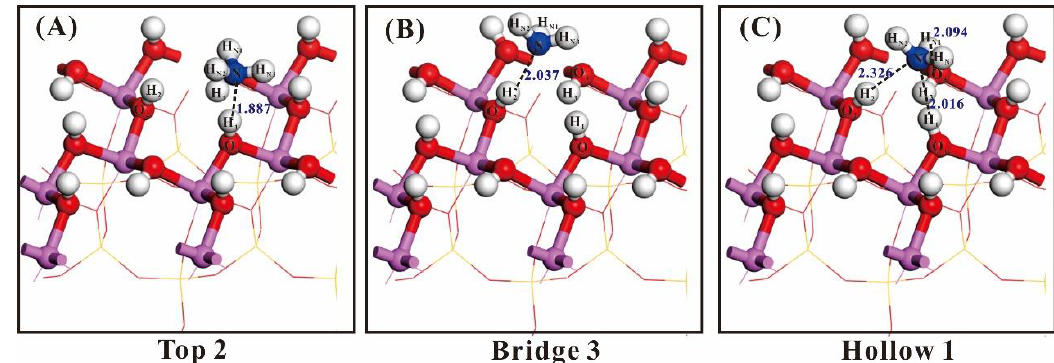
Figure 5. Bond formation and bond length of NH 3 adsorbed at the position of “Top2”, “Bridge3” and “Hollow1” (the white ball: H; the red ball: O; the blue ball: N; the purple ball: Al). ( A ) is the “Top2” position, ( B ) is the “Bridge 3” position, ( C ) is the “Hollow 3” position. After adsorbing NH 3 on the kaolinite (001) surface, the Mulliken populations between N atoms